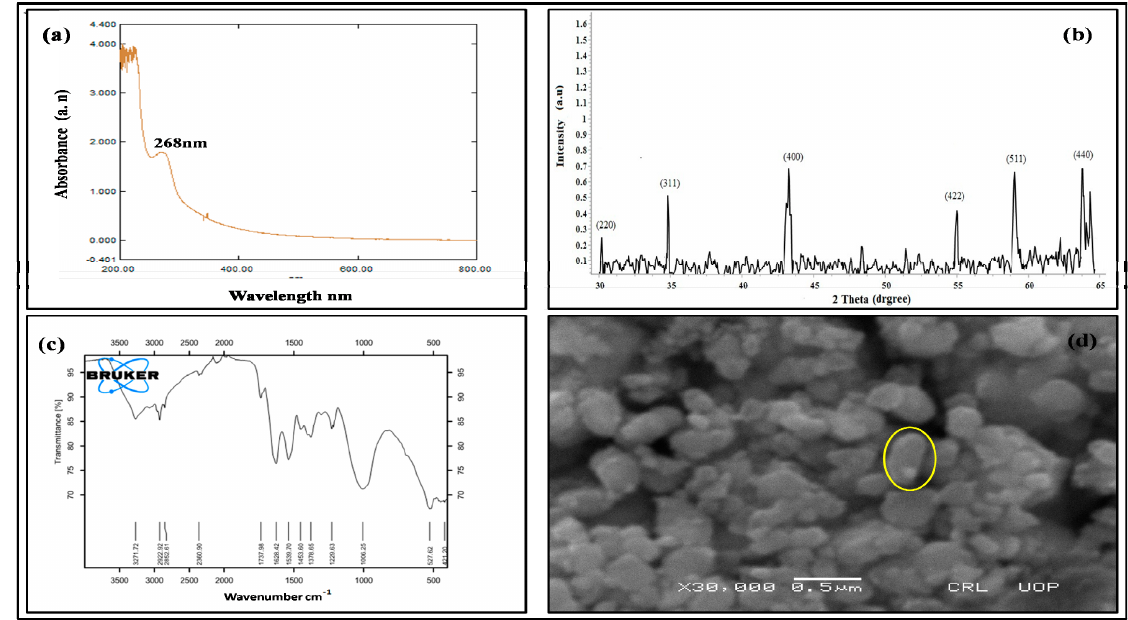
Figure 1. Representative UV-Vis absorption spectra ( a ), XRD pattern ( b ), FTIR spectra ( c ), SEM image, 0.5 µm scale ( d ) of iron oxide nanoparticles synthesized by adding 15 mL of iron oxide suspension with 5 mL of Bacillus subtilus extract.